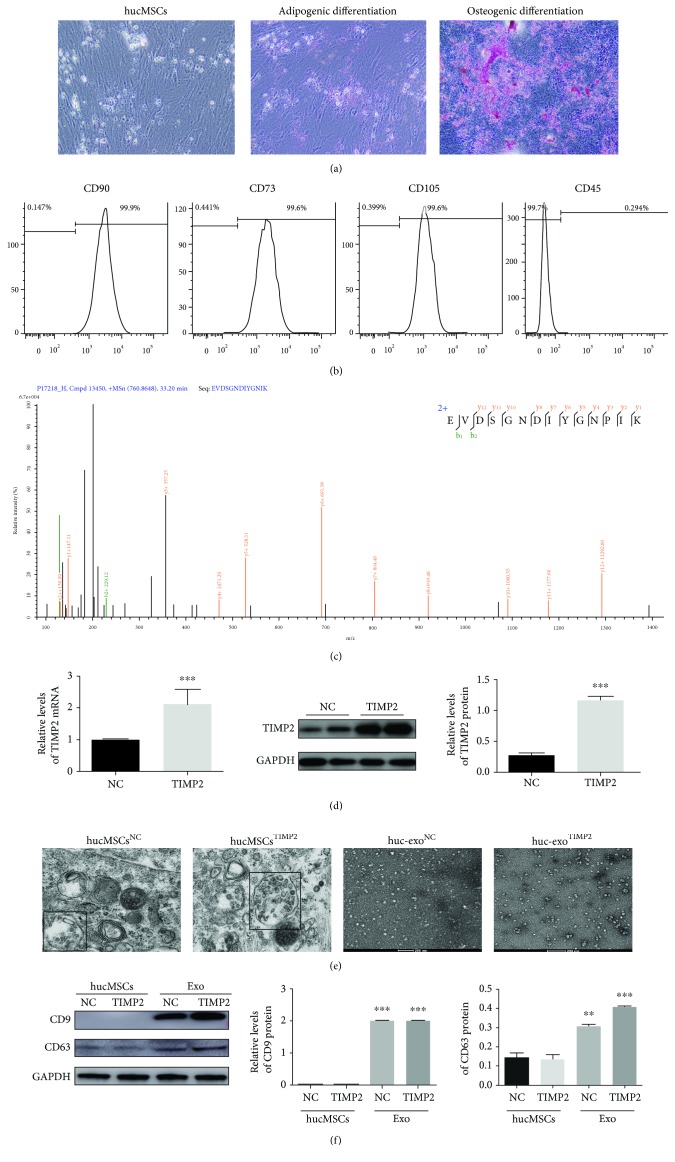
Characterization of hucMSCs and hucMSC-derived exosomes. (a) Representative images of spindle-shaped hucMSCs and terminally differentiated adipogenic (Oil Red O-stained) and osteogenic (alizarin A-stained) cells. Scale bar: 50 μm. (b) Flow cytometric plots showing enriched CD90+, CD73+, CD105+, and CD45- hucMSCs. (c) Mass spectrometry results of the TIMP2 level in hucMSC-derived exosomes. (d) Quantification of TIMP2 mRNA and protein expression in TIMP2-transfected hucMSCs. (e) TEM micrographs showing the morphology of hucMSCNC- and hucMSCTIMP2-derived exosomes. Scale bar: 500 nm/200 nm. (f) Immunoblots showing the expression levels of CD9 and CD63 in hucMSCsNC, hucMSCsTIMP2, huc-exoNC, and huc-exoTIMP2. ∗p < 0.05, ∗∗p < 0.01, and ∗∗∗p < 0.001.